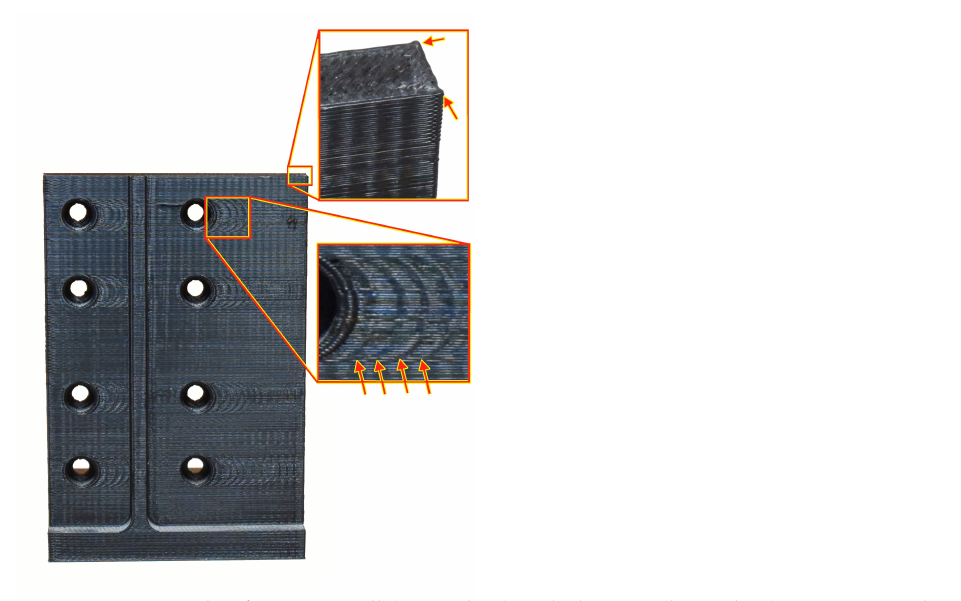
Figure 1. Example of corner swell (upper box) and ghosting (lower box). Arrows mark typical variants of these